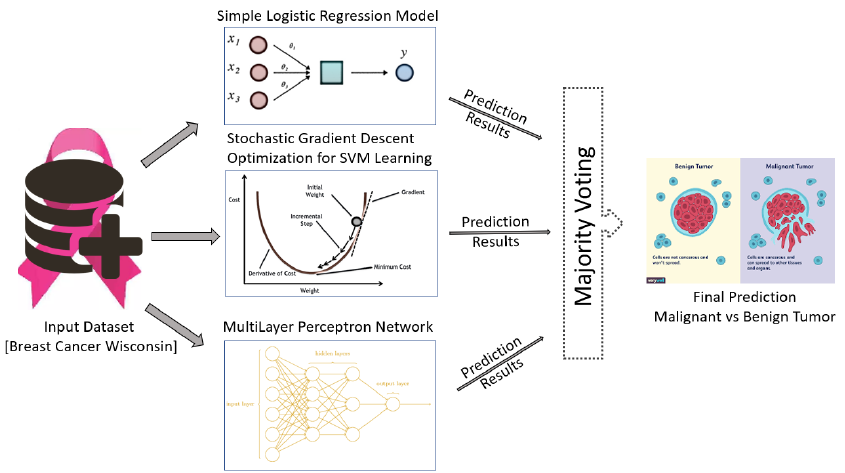
Figure 1. An ensemble method based on majority-based voting mechanism for breast cancer tumor classification using different machine learning